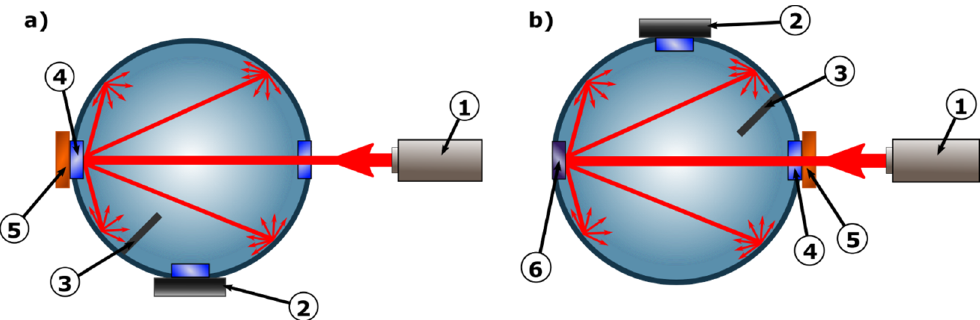
Figure 3. Principle of operation of a measurement system, ( a ) in reflectance mode and ( b ) in diffuse transmittance mode, where: 1—light source, 2—luxmeter, 3—baffle, 4—sample port, 5—optical phantom, 6—unused plugged port [27].